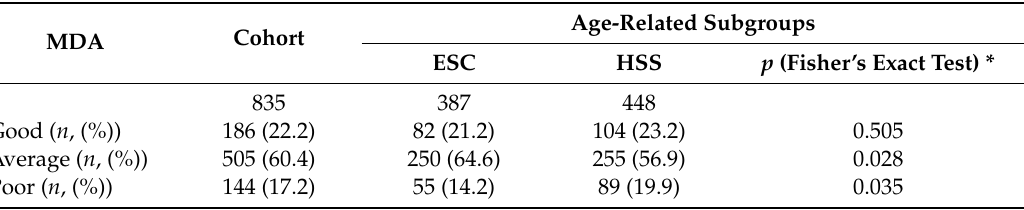
Table 2. Mediterranean diet adherence-related categories in the cohort and the two age-related subgroups.